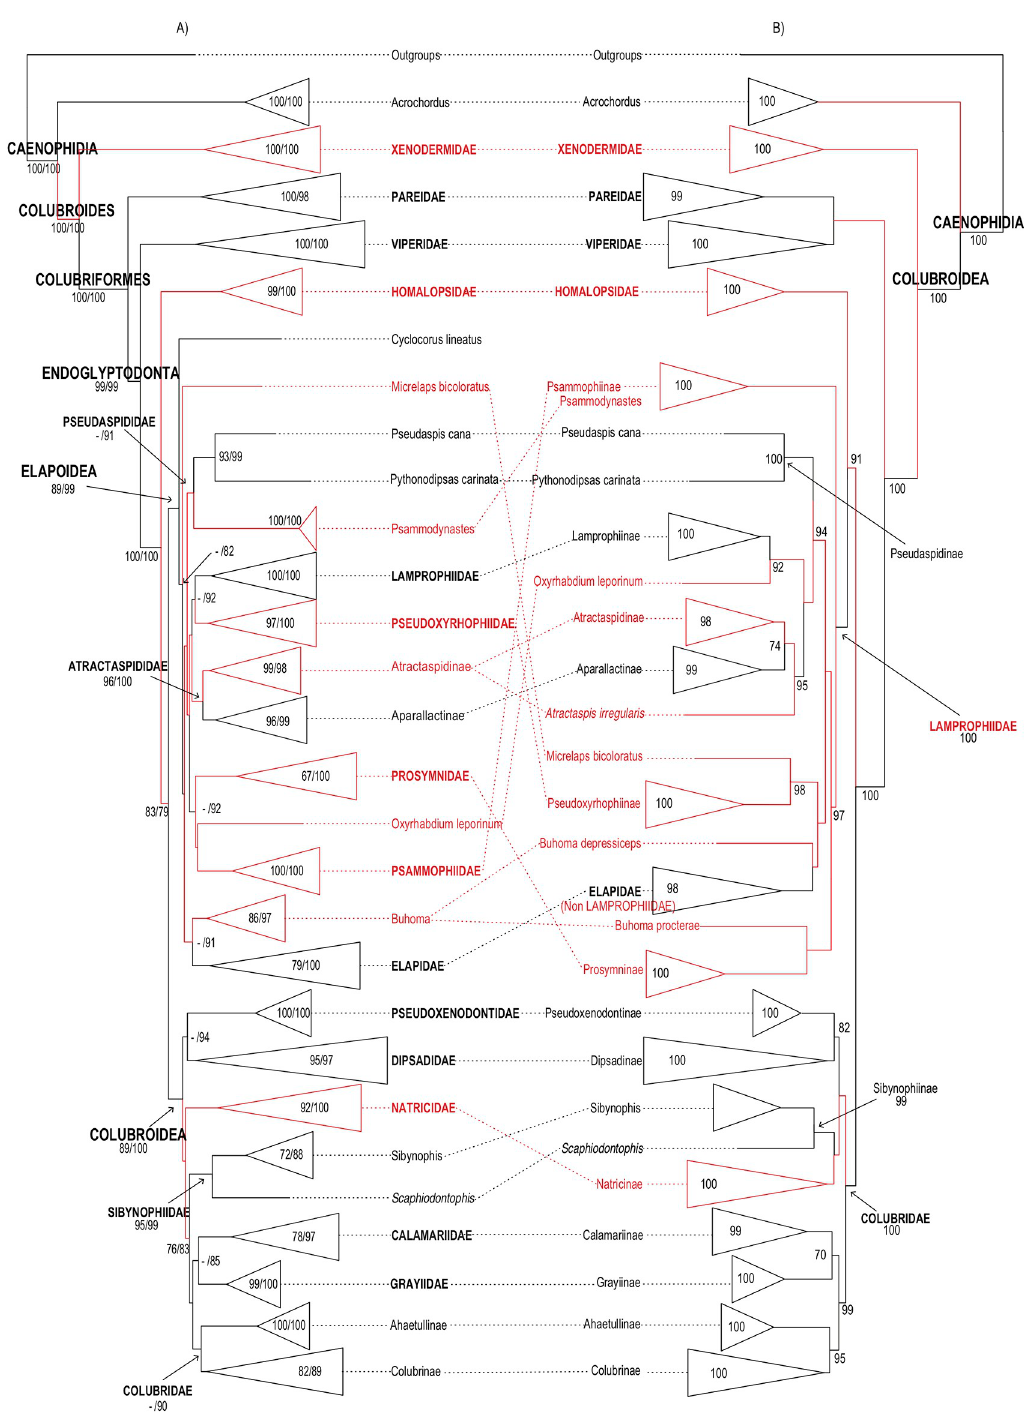
Fig 1. Higher-level caenophidian phylogenies. Comparison between Maximum-likelihood phylogenetic estimates from (A) the present study and (B) Figueroa et al. [28]. Tips represent commonly recognized families, subfamilies and rogue taxa. Names in red correspond to taxa with distinct phylogenetic positions in the topologies compared. Numbers on each branch and within expanded tips correspond to our and previously reported support values: (A) FBP (left) and SHL (right); (B) FBP. Branches without numbers have support <